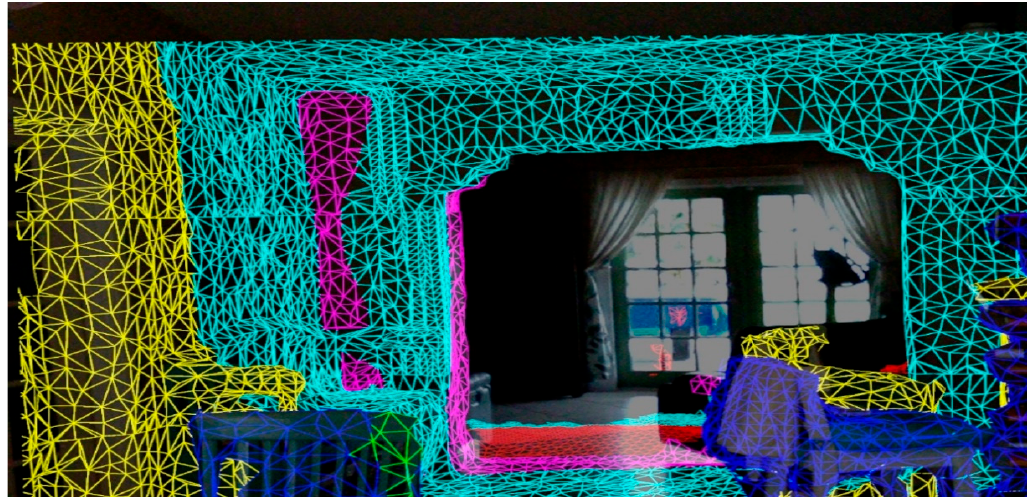
Figure 2. Magic Leap One™ room scan, creating a mesh of the environment. Source: University of Miami IT Department.